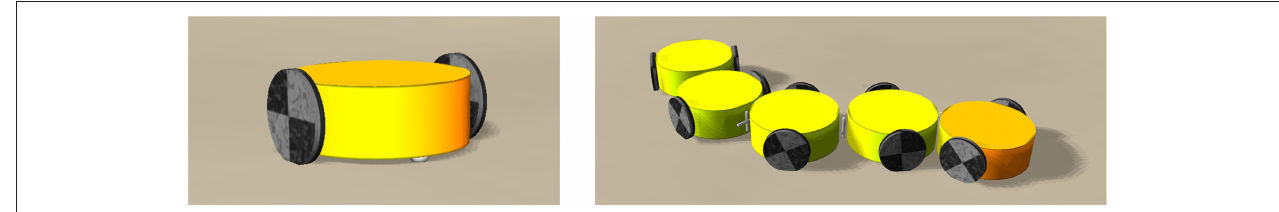
FIGURE 7 | Snapshots from the LPZRobots simulations environment (Der and Martius, 2012) of two-wheeled car-like and train-like robots. Left : The two active wheels (black) are controlled as described in section 2.2. The passive support wheel (white) below the body (yellow) prevents the car from tipping over (click for movie). Right : A train robot created by connecting cars via passive torsion springs (click for